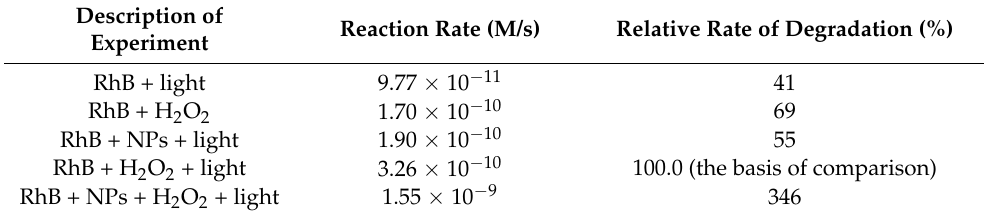
Table 1. Design of control experiments for rhodamine B (RhB) degradation. Experimental condi- tions: concentration of NP-3 = 400 mg/L, concentration of RhB = 1.75 × 10 −5 mol/L, concentration of